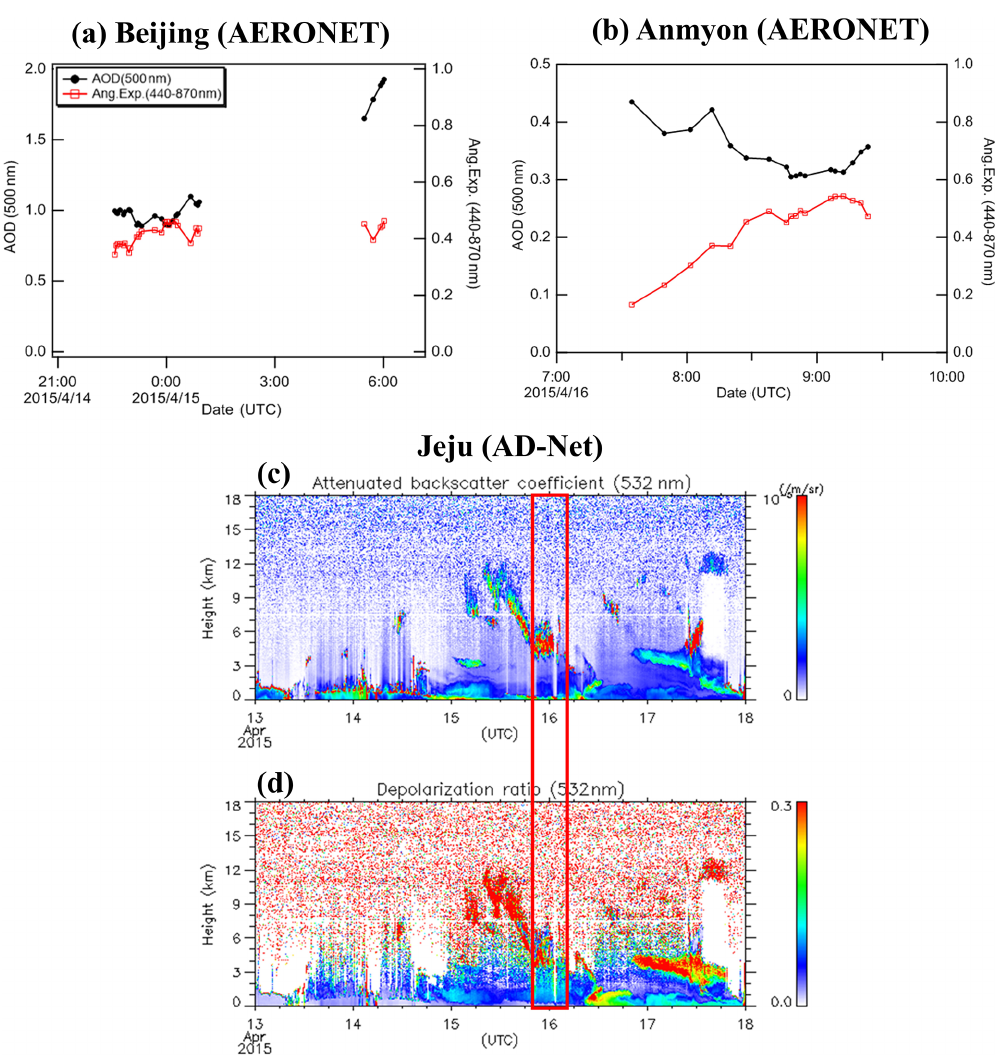
Figure 6. Aerosol optical properties observed at ground-based sites during CASE I. (a) AOD (500nm) and Angström exponent (440–870nm) at the Beijing AERONET site. (b) AOD and Angström exponent at the Anmyon AERONET site. Vertical profiles of (c) backscattering coefficient and (d) depolarization ratio at the Jeju AD-Net site. The red rectangle denotes the time when dust passed over the site. Clouds are screened and represented by the blank